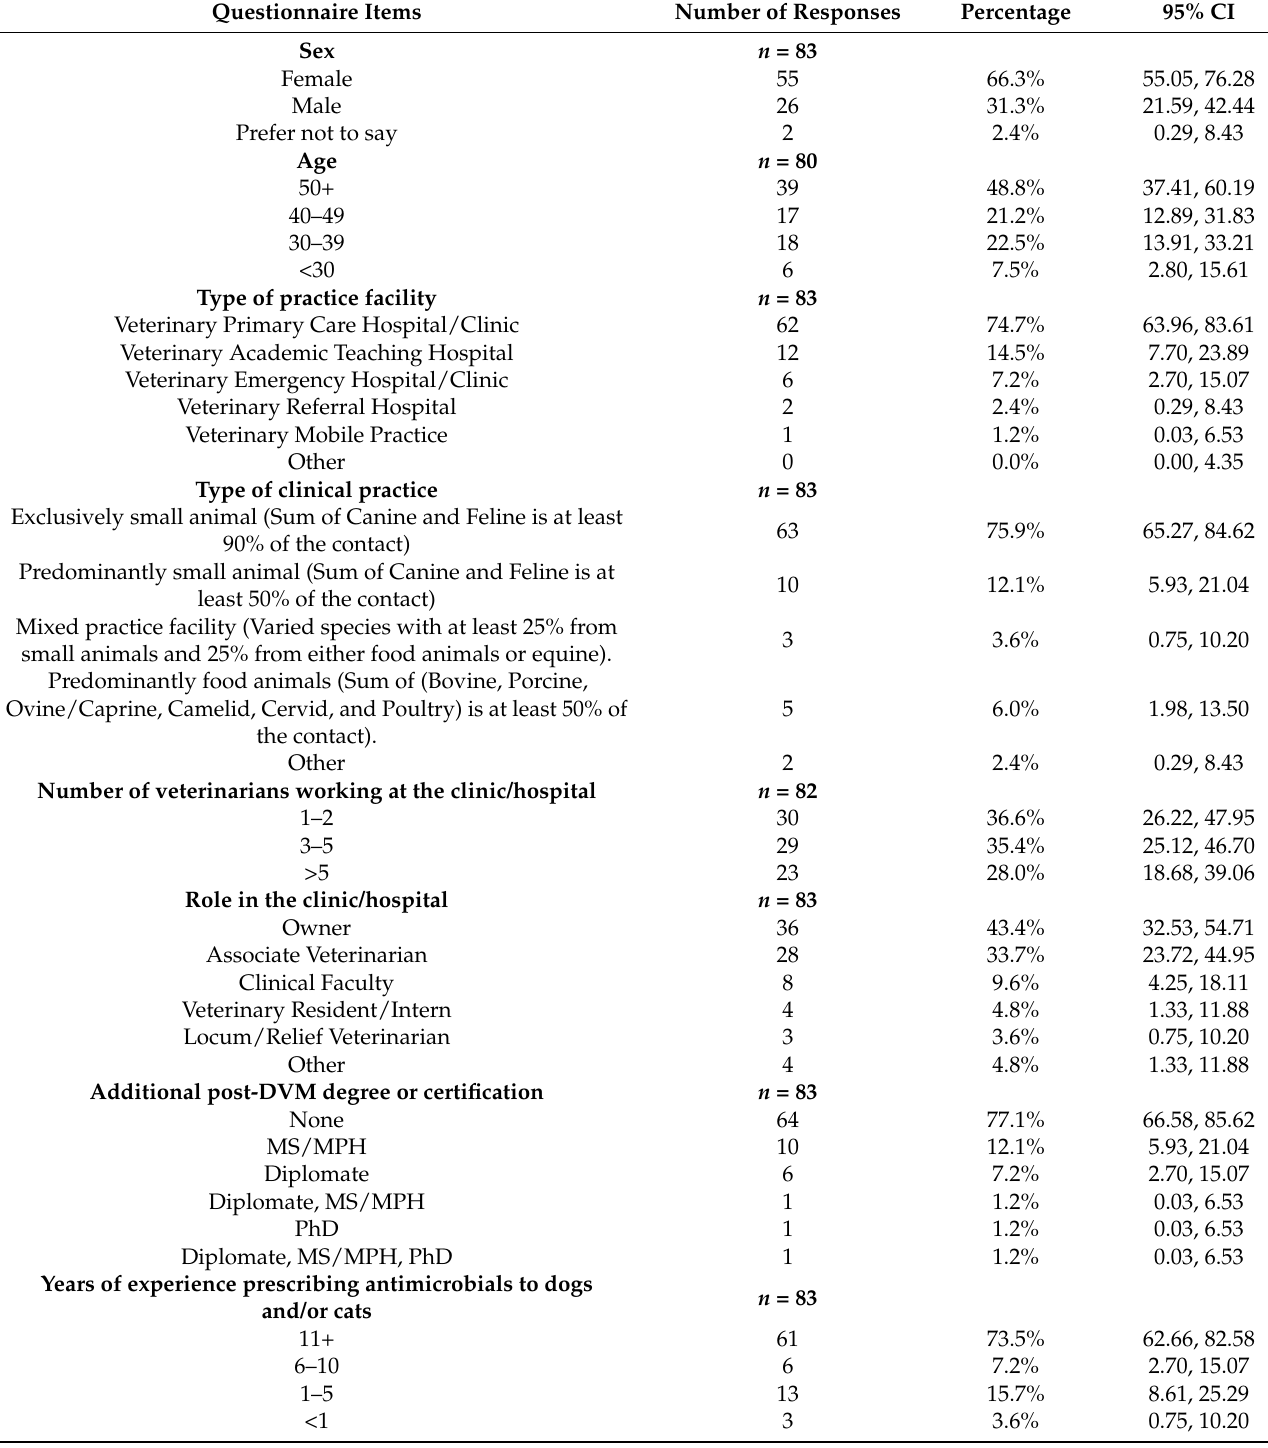
Table 1. Demographic characteristics of Illinois small animal